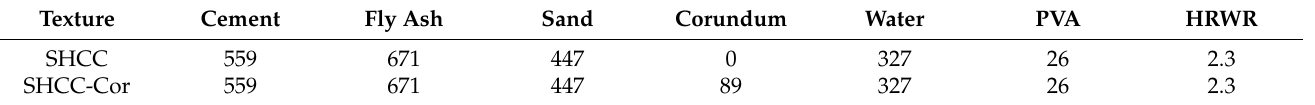
Table 1. Mixture design of SHCC and modified SHCC-Cor.